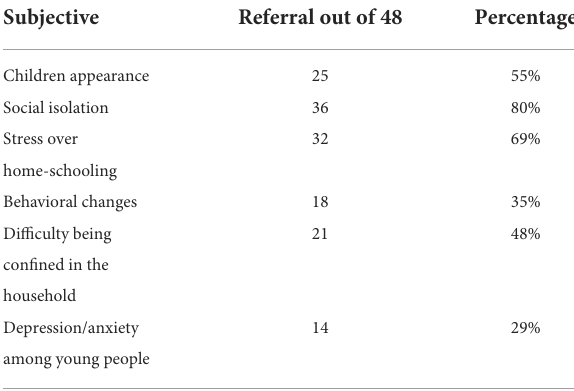
TABLE 3 The referral and percentage of qualitative